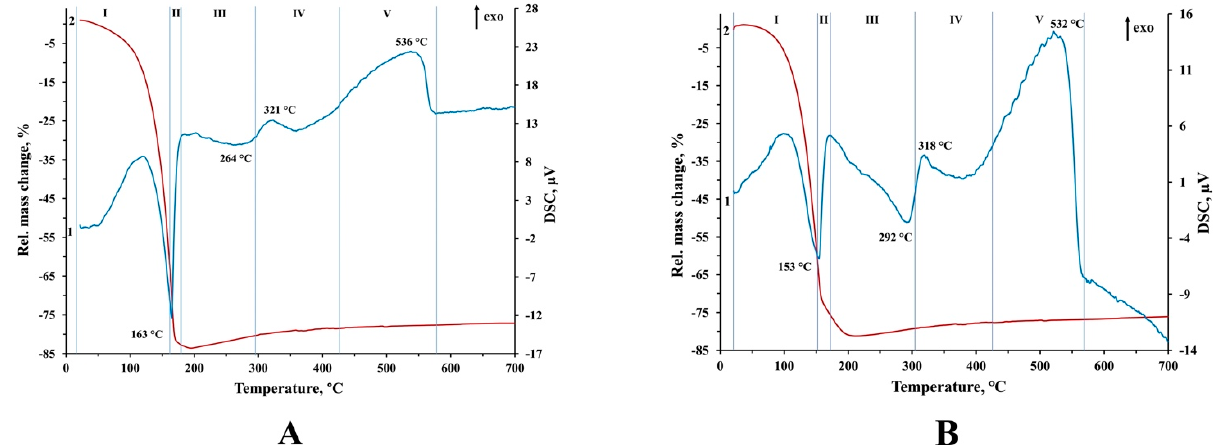
Figure 1. DSC (1) and TGA (2) curves of the precursors produced by extraction–pyrolytic method (EPM): ( A ) E1; ( B ) E2.